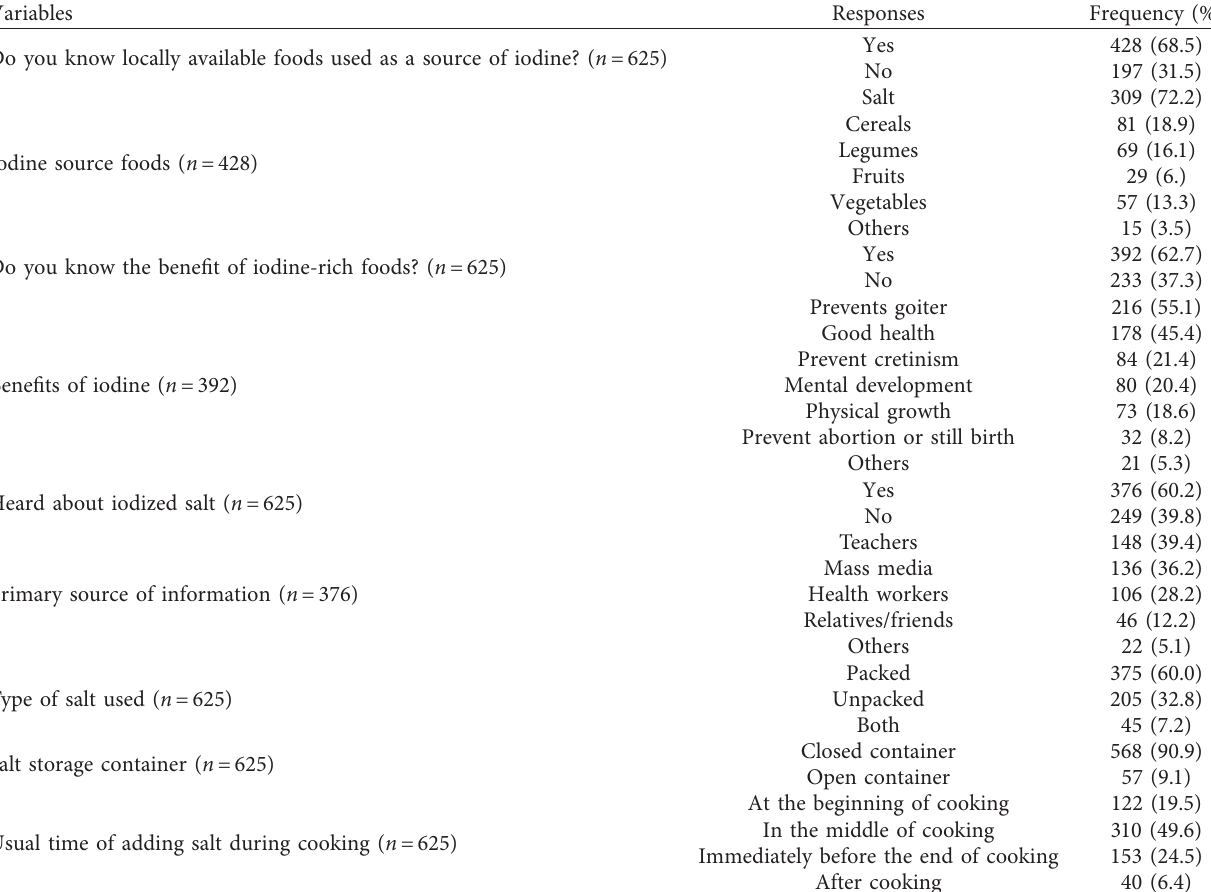
Table 4: Knowledge about the benefits and food sources of iodine by study participants, 2019.